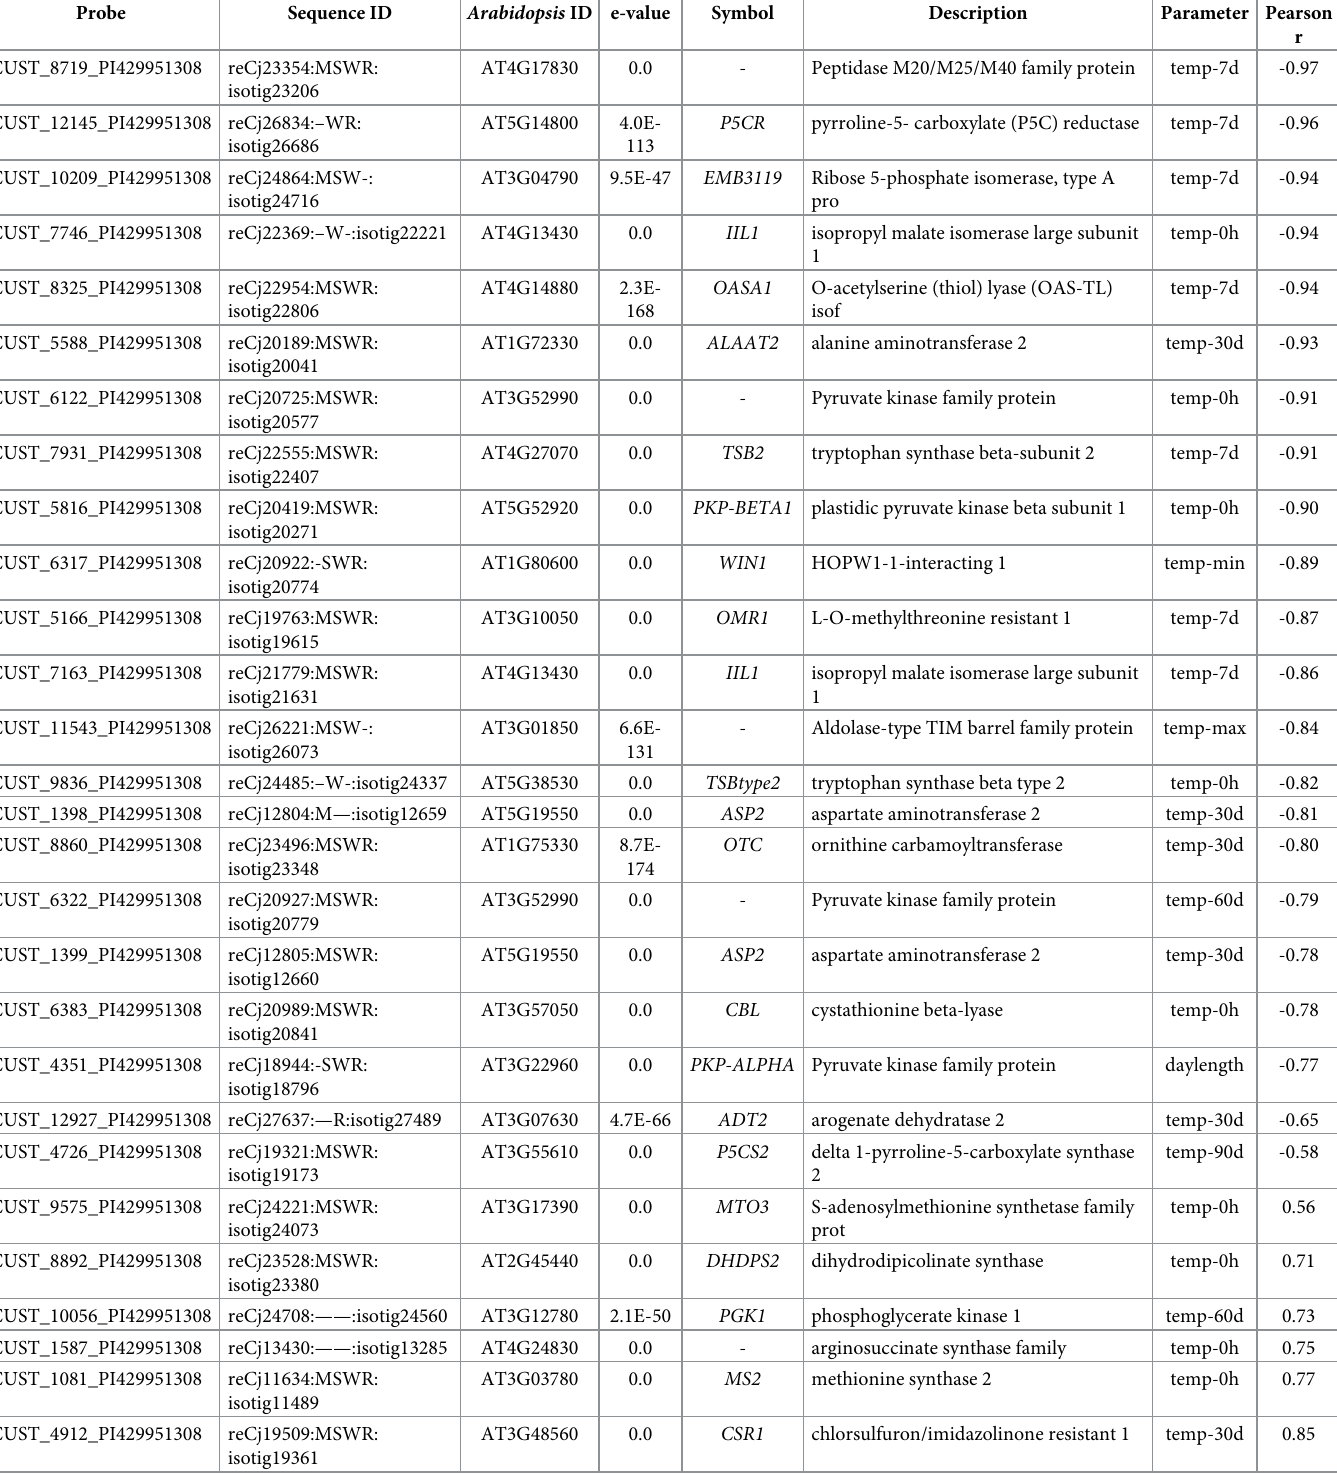
Table 8. Amino acid–related genes exhibiting differential expression patterns among the three sites.